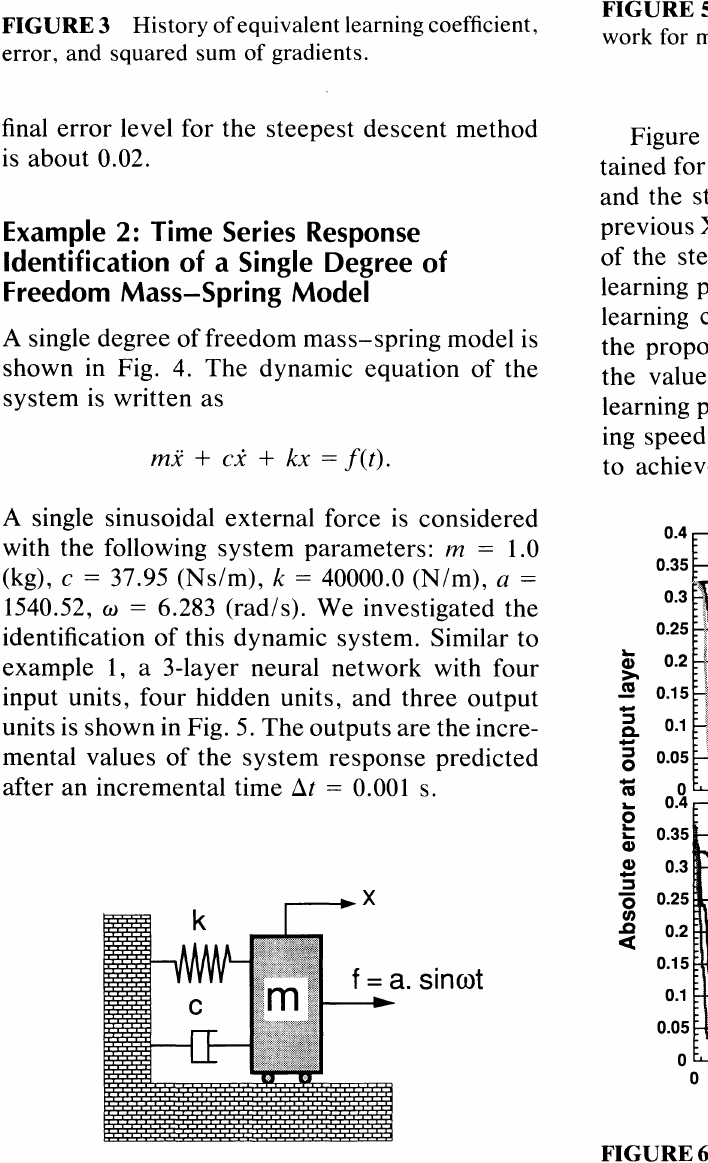
FIGURE 4 Single degree of freedom linear mass spring model.